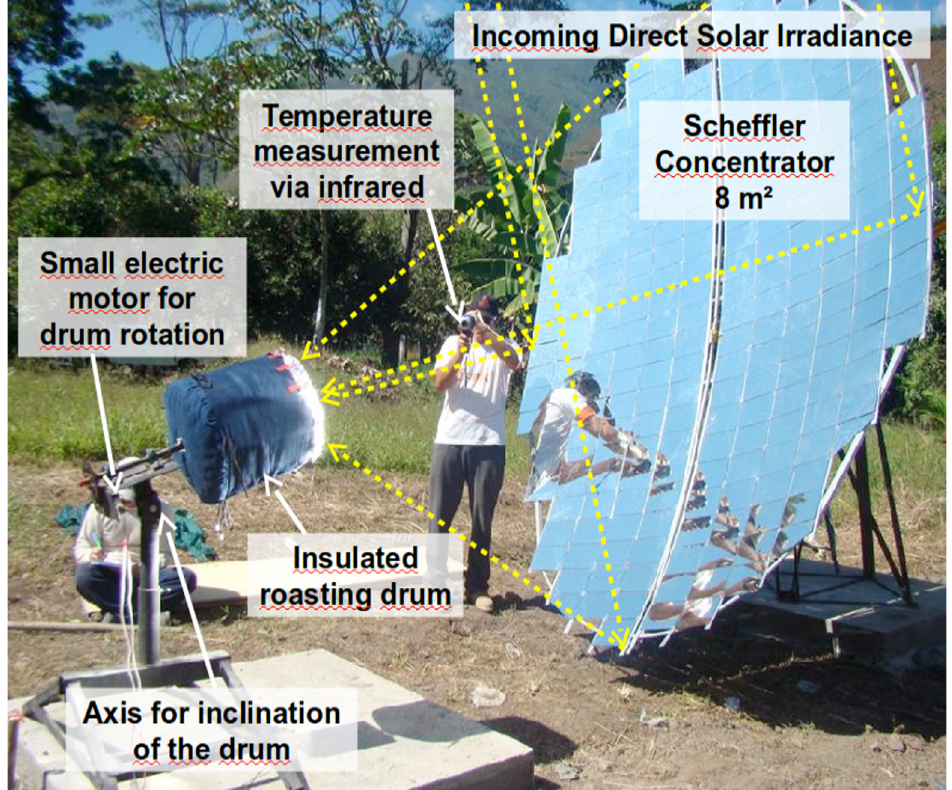
Fig. 1. Photo of the solar roasting technology, showing the path of light towards the focal